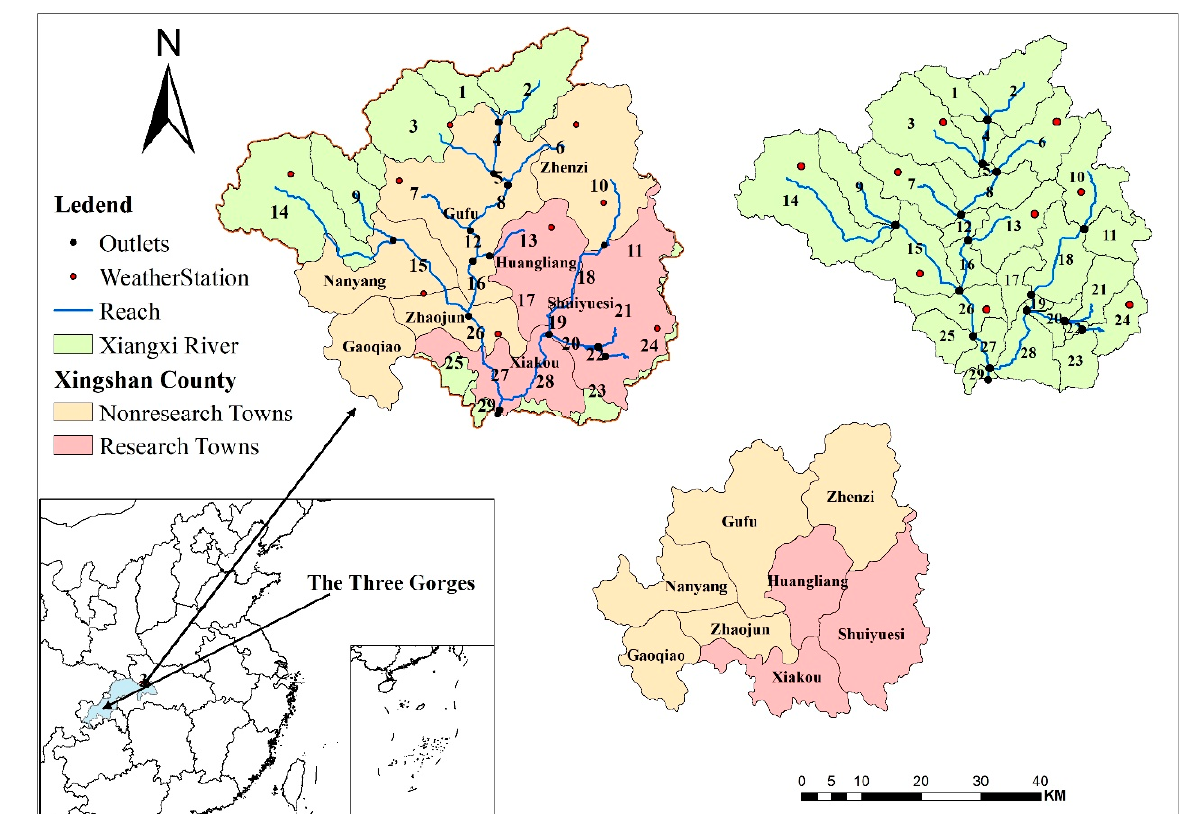
Figure 1. The map of study area.